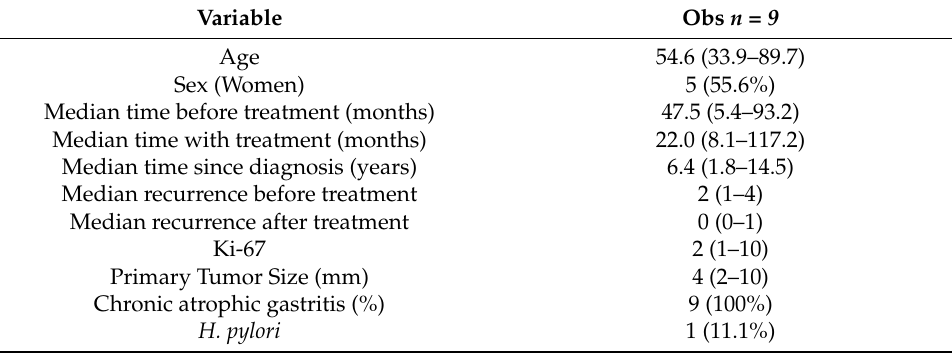
Table 1. General features of the patients included in the study.